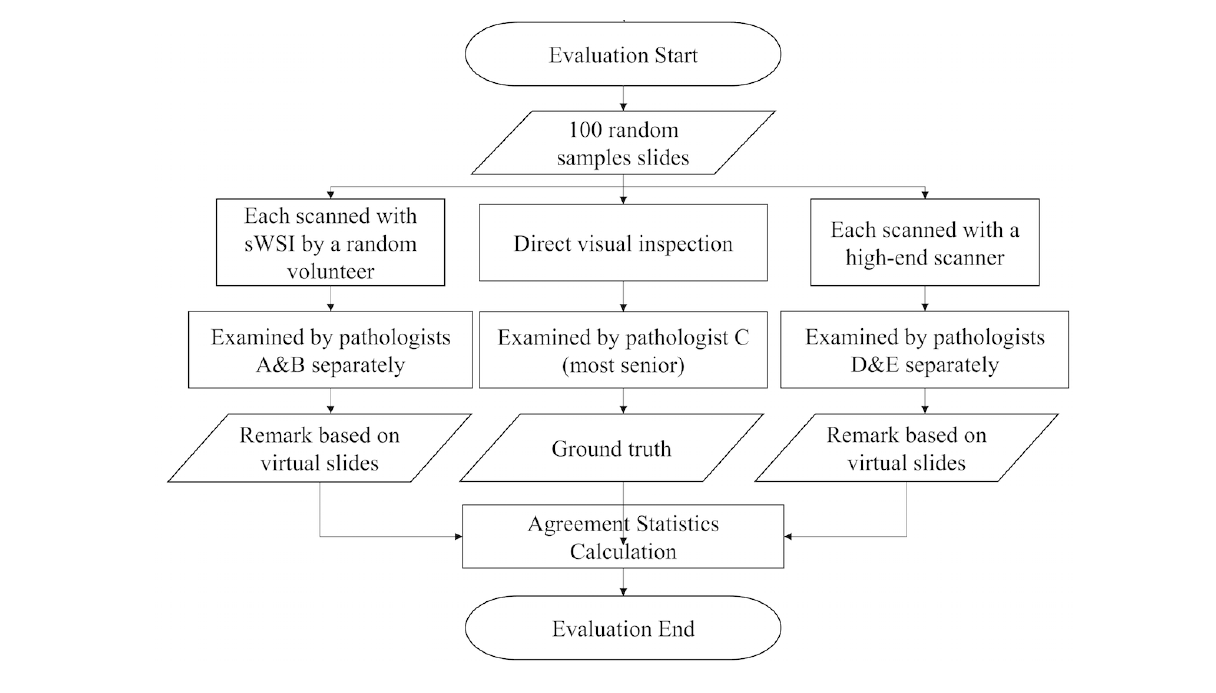
Figure 7. sWSI clinical evaluation